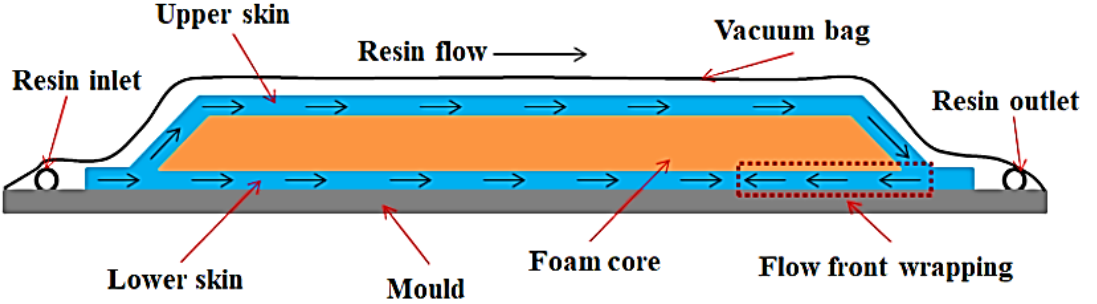
Figure 5. The reverse flow of resin in the upper and lower skins in vacuum-assisted resin injection molding [74]. Reproduced with permission from MDPI.